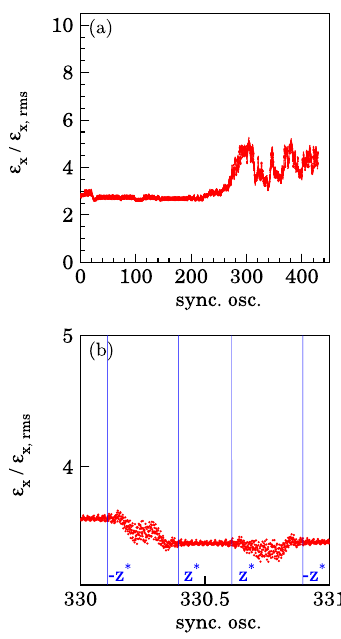
FIG. 15. (a) Evolution of the horizontal Courant-Snyder invari- ant of a test particle over 430 synchrotron oscillations. (b) Evolution of the horizontal invariant over a single synchrotron period, experiencing four resonance-induced kicks.